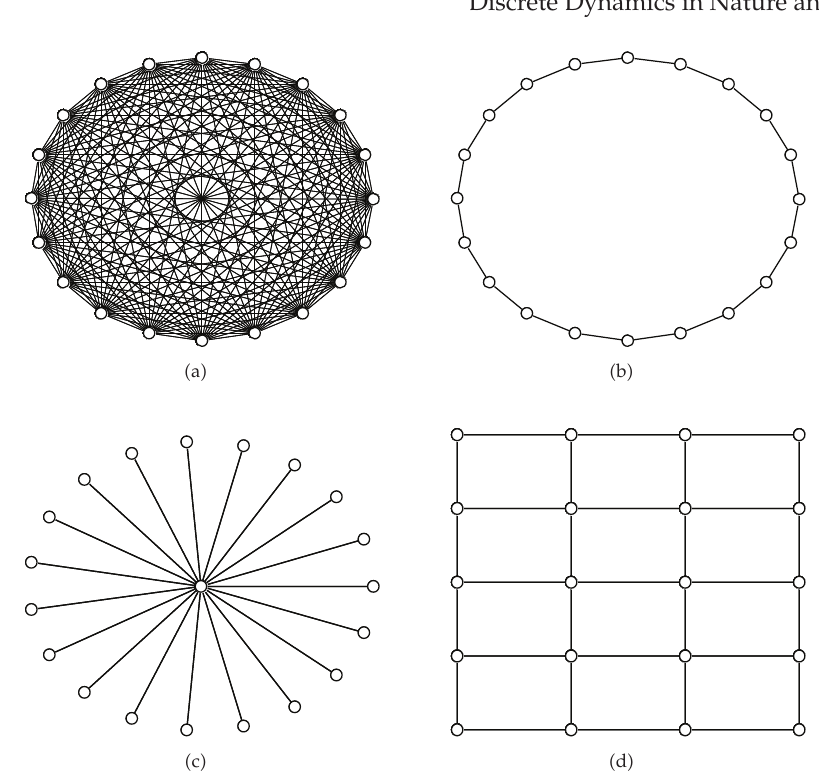
Figure 4: Four interaction topologies for PSO: (cid:2) a (cid:3) fully-connected, (cid:2) b (cid:3) ring, (cid:2) c (cid:3) star, (cid:2) d (cid:3)